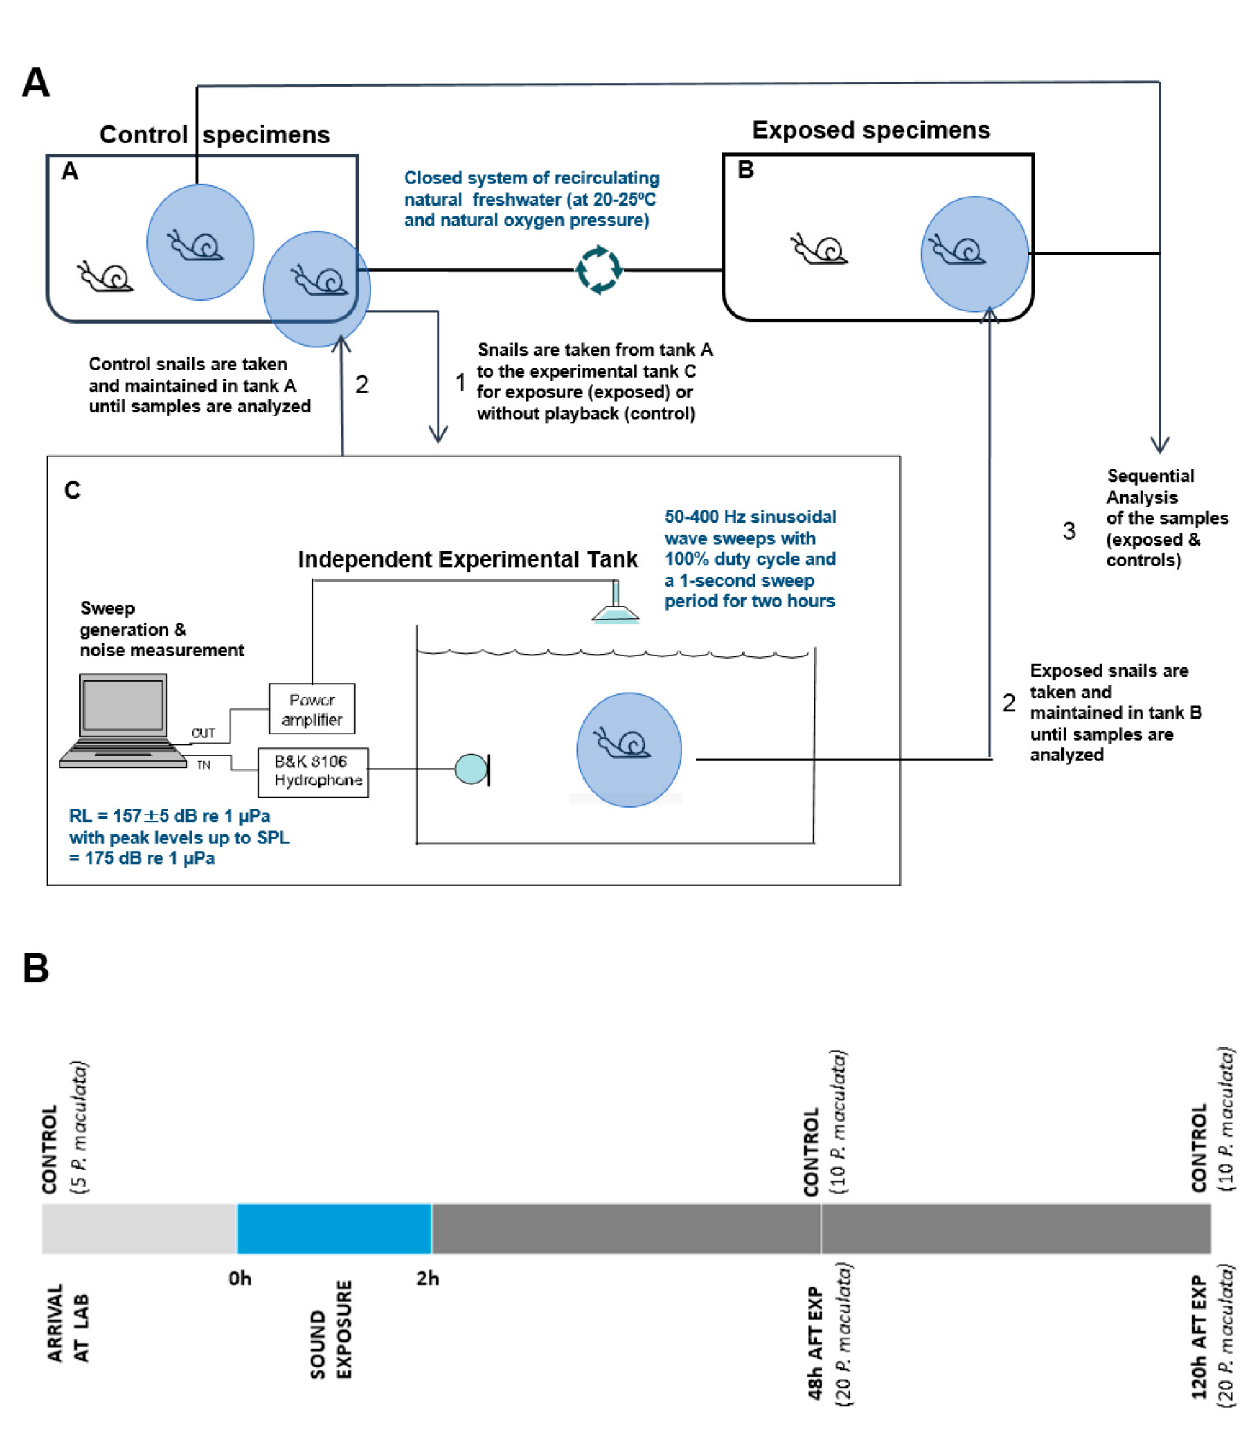
Figure 3. Sound exposure protocol, sampling collection, and analysis. ( A ): Sound exposure protocol. P. maculata were maintained in tank A until some were transferred to an independent experimental tank C where they were exposed to sound (1). At the end of the exposure experiments, the snails were transferred to tank B (2) that presented the same environmental conditions as tank A. Control specimens were transferred to tank C for 2 h without any playback and after that, they were taken back to tank A (2). Samples of control and exposed plants were sequentially taken for analysis (3). (Figure modified from 38). ( B ): Sampling collection and analysis. Before the sound exposure started, control specimens were taken and analyzed at the arrival of the laboratory facilities. Samples of control and exposed snails were sequentially analyzed at 48 h and 120 h after sound exposure.